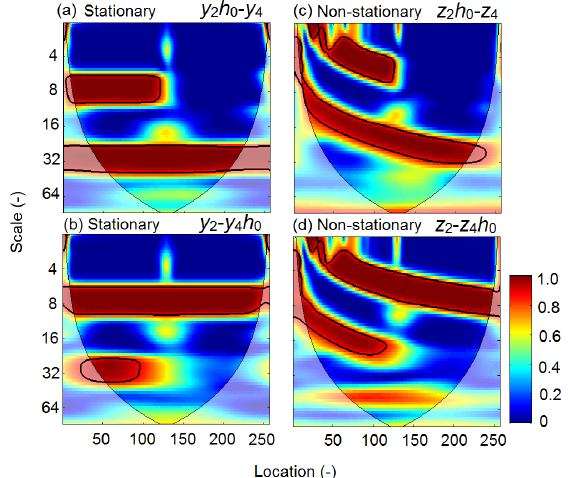
Figure 3. Multiple wavelet coherence (a) between y and y 2 h 0 and y 4 ; (b) between y and y 2 and y 4 h 0 ; (c) between z and z 2 h 0 and z 4 ; and (d) between z and z 2 and z 4 h 0 . The variables y 2 h 0 (or z 2 h 0 ) and y 4 h 0 (or z 4 h 0 ) refer to the new series of y 2 (or z 2 ) and y 4 (or z 4 ), in which the second half is replaced by 0.